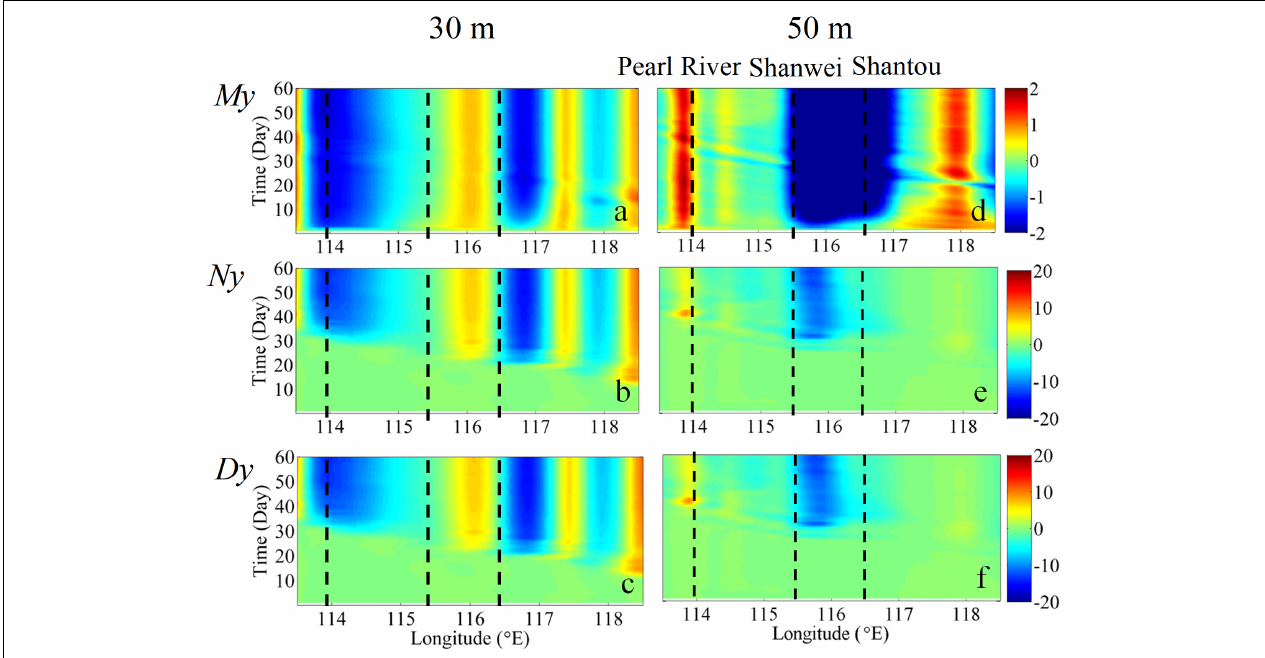
FIGURE 10 | Time series of the depth-integrated volume flux (m 2 s − 1 ) (upper panel), nitrate flux (mmol m − 1 s − 1 ) (middle panel), and detritus flux (mmol m − 1 s − 1 )